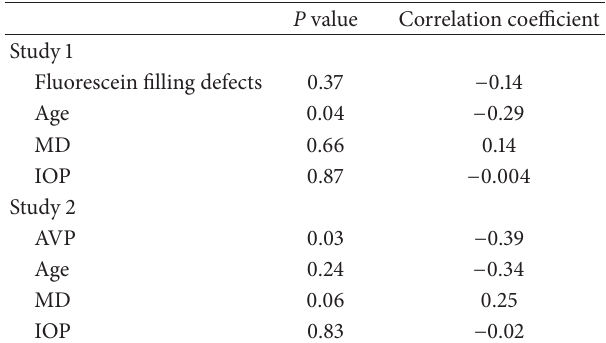
Table 2: Multivariate correlation analysis of visual field progression (MD progression per year) in patients with NTG of study 1 (fluores- cein filling defects) and study 2 (AVP) with fluorescein angiographic parameters and clinical